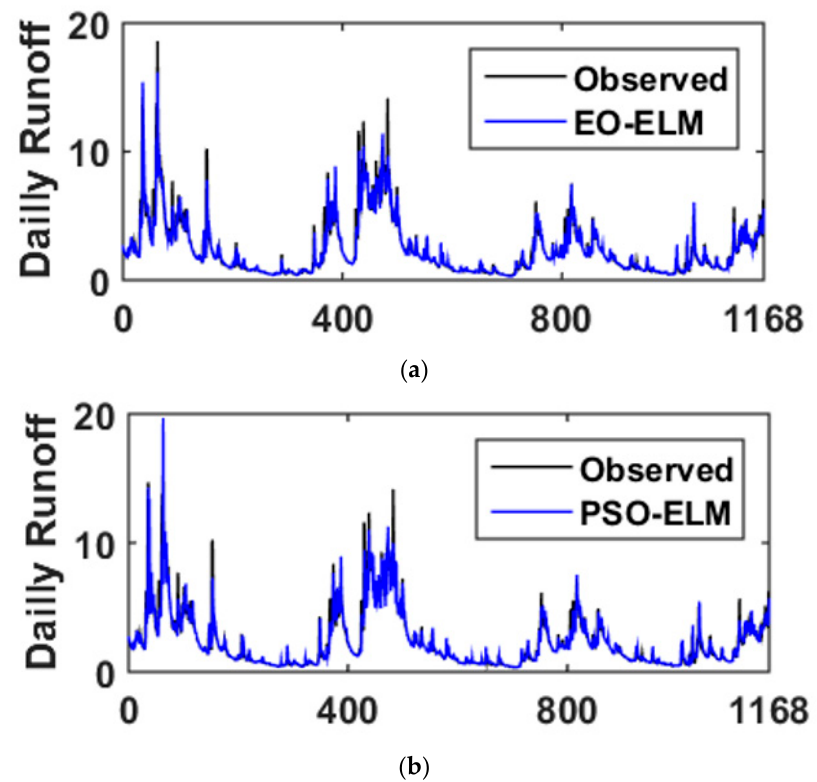
Figure 9. Test case observe vs. predicted runoff of ( a ) EO-ELM and ( b ) PSO-ELM for catchment Fal at Tregony.